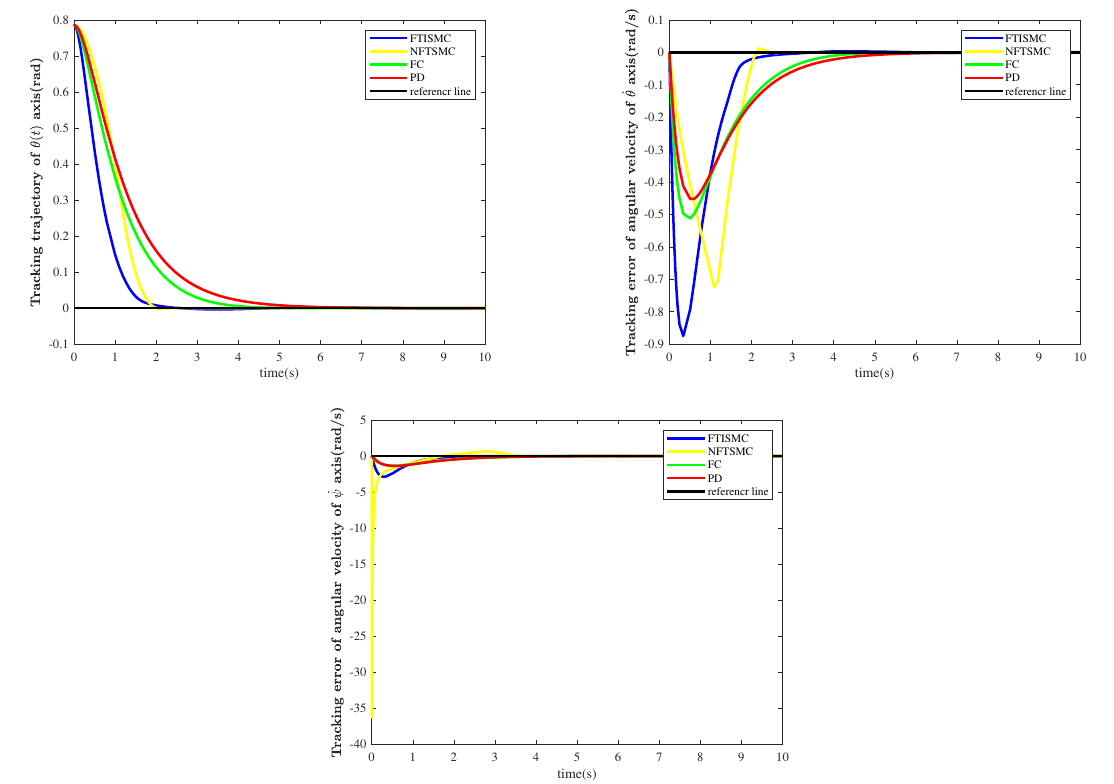
Figure 4. Attitude angle tracking trajectories of different controllers.